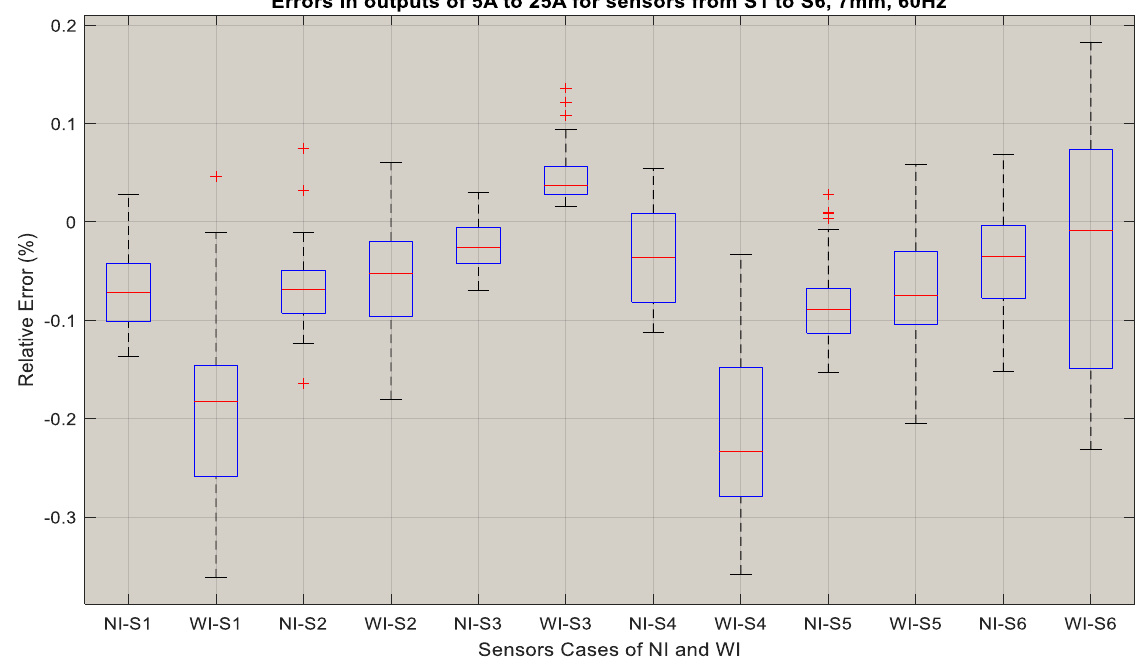
Figure 13. Sensor S4 outputs for currents of 5 A to 25 A: WI and NI cases.